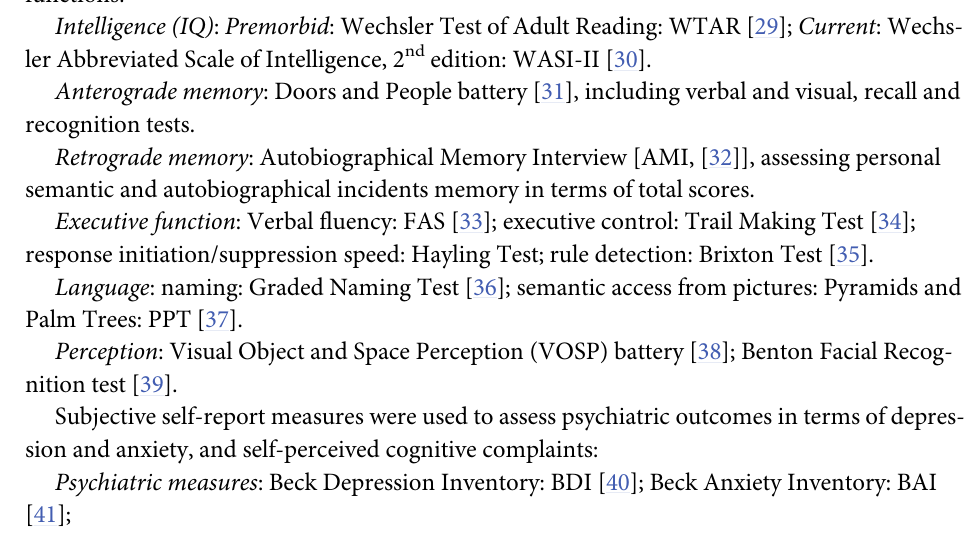
The means (SD) and frequencies of demographic characteristics of the participants in this study. Statistical analyses reported here include ANOVA ( F ) and Chi-Squared Test of Independence ( X 2 ). GCS score at admission was not available for the long-term outcome cohort. Abbreviations : SD (Standard Deviation) , GCS (Glasgow Coma Scale)